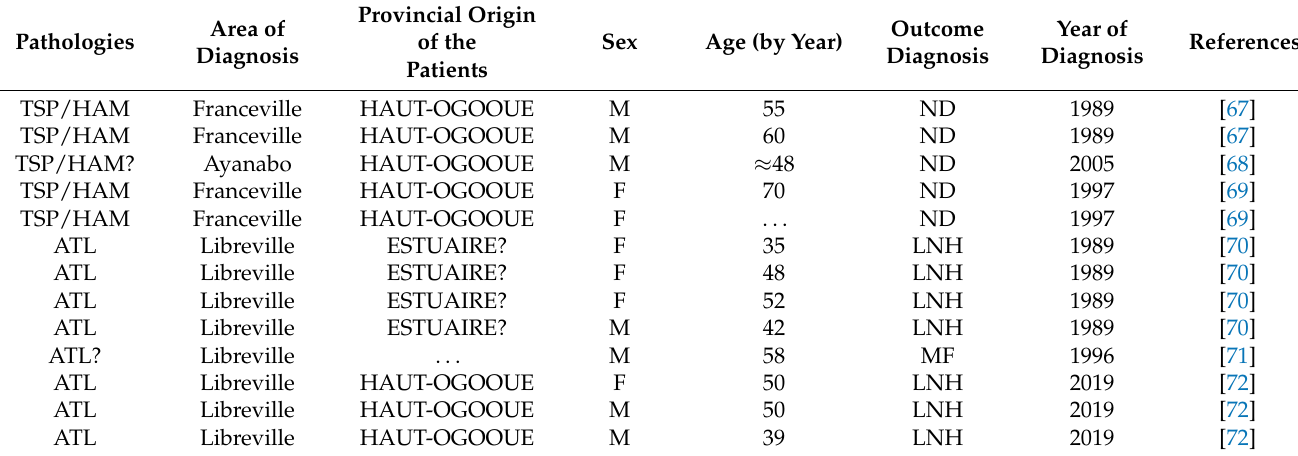
Table 2. Cases of pathologies associated with the HTLV-1 infection in